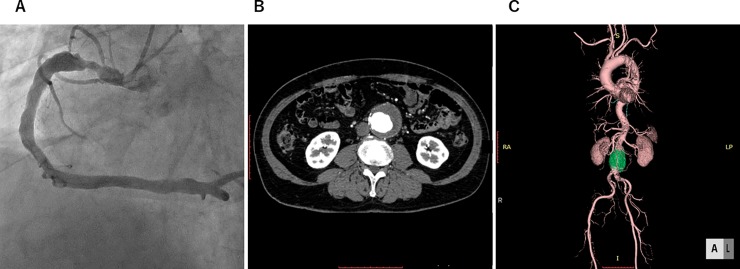
A representative case of coronary artery ectasia.Images of a 62-year-old man with an abdominal aortic aneurysm. Diffuse ectasia and focal stenosis in the right coronary artery are seen (A). The axial image (B) and 3D reconstruction image (C) of computed tomography show an infra-renal aortic aneurysm.